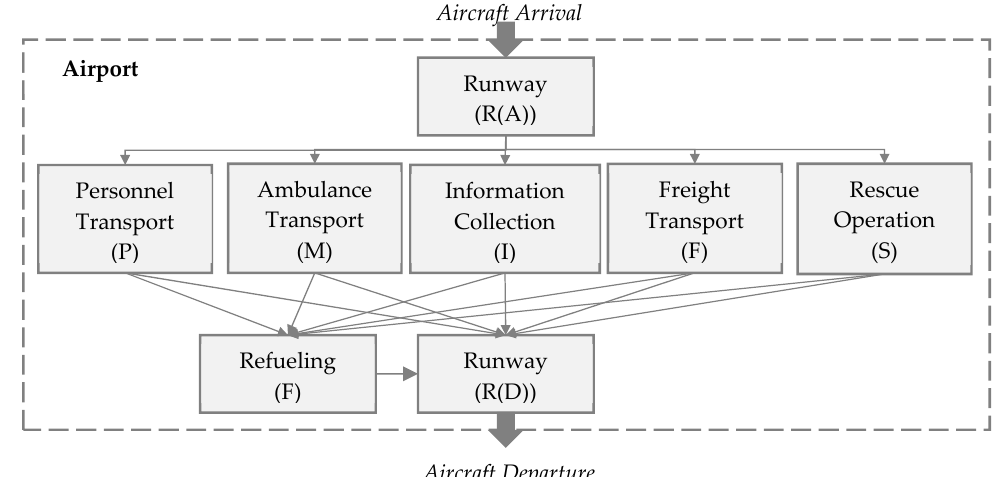
Figure 1. Open Jackson network model for an airport while responding to a disaster.